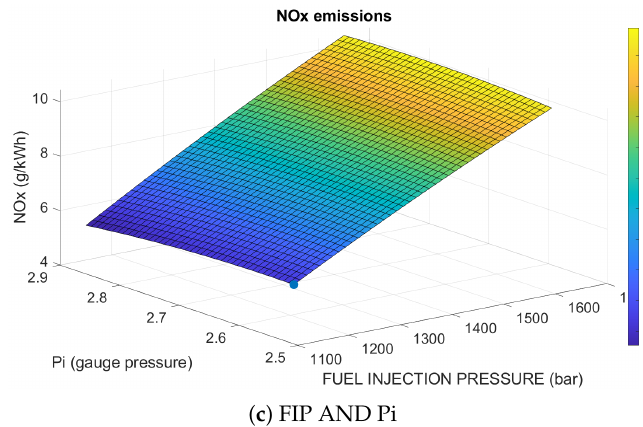
Figure 9. Response surface of the NO x at one operating point.